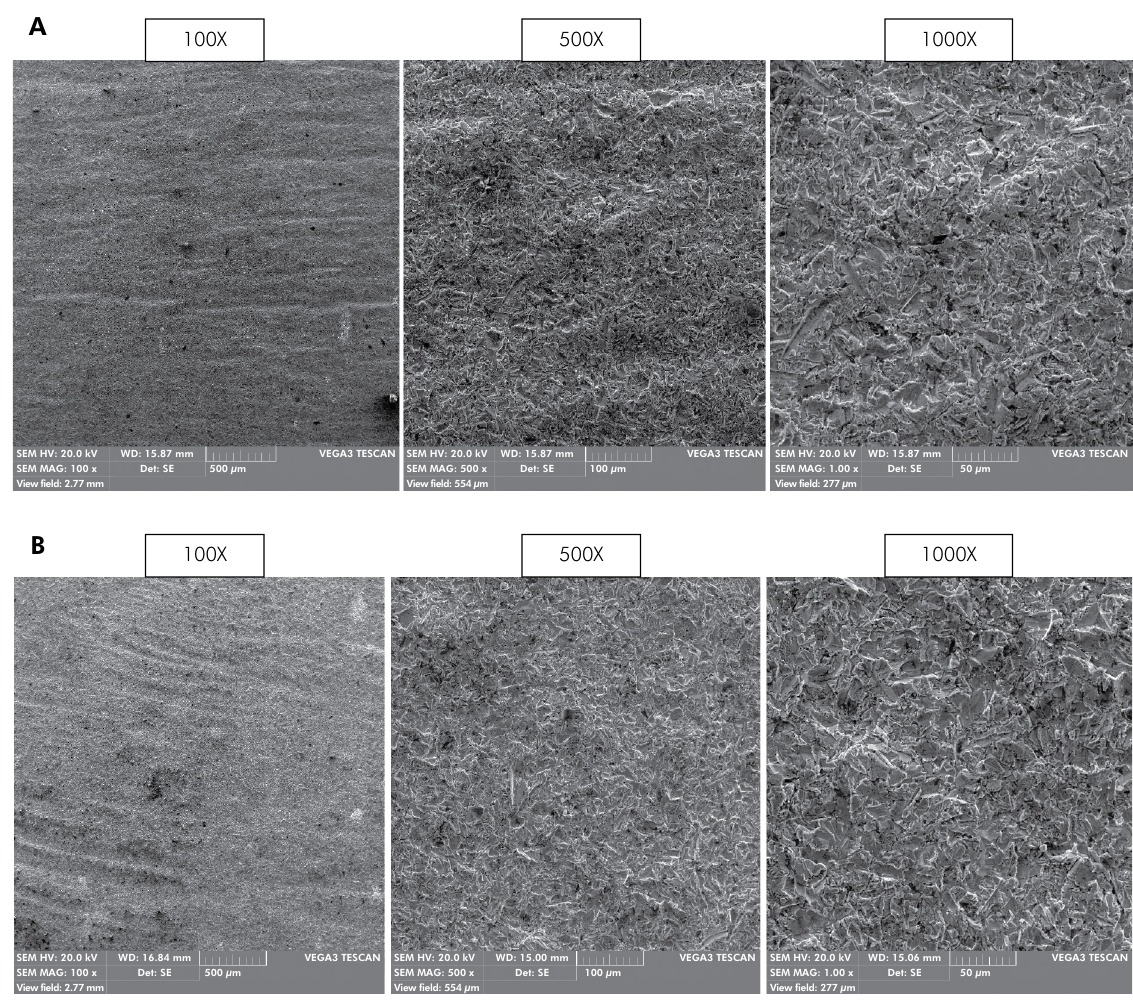
Figure 1. Scanning electron microscopy (SEM) of untreated metal implant surfaces (A) and surfaces treated with phosphoric acid (B).